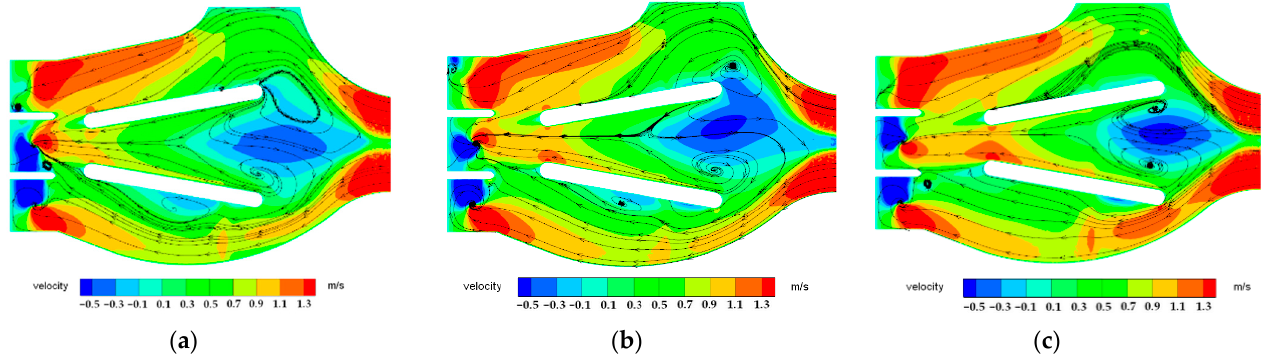
Figure 11. Comparison of bottom streamline and velocity cloud images at different distances. ( a ) 0.1 L, ( b ) 0.15 L, and ( c ) 0.2 L.